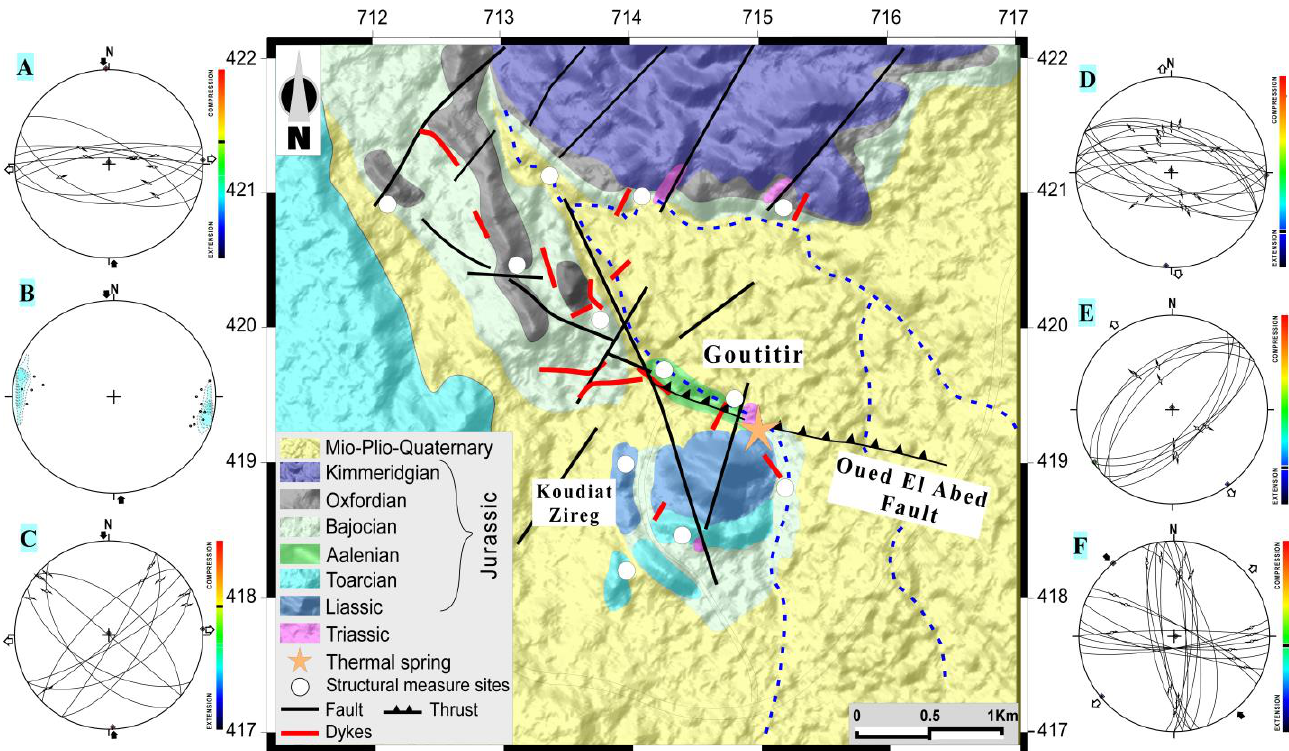
Figure 2. Simplified geological map of the Goutitir thermal spring zone. The stereograms ( A – F ) represent the different tectonic structures affecting this region.